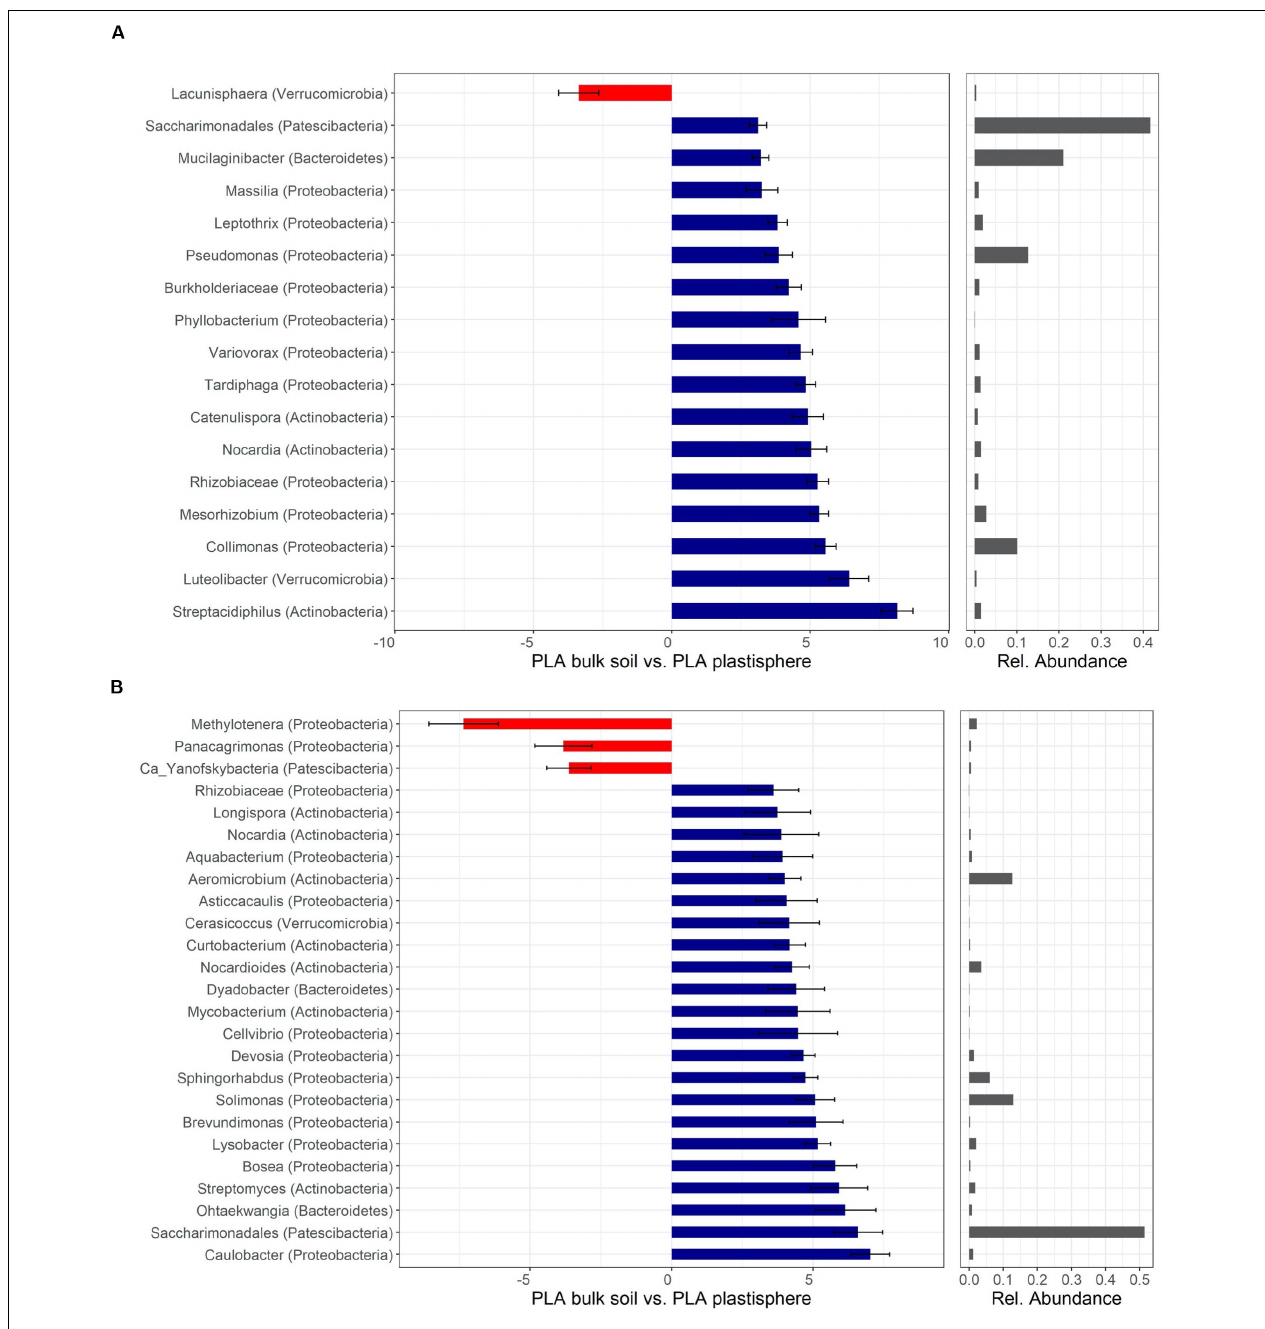
FIGURE 5 | Differentially abundant taxa of PLA in Barba Peider (Swiss Alps) (A) and Villum (Northern Greenland) (B) soil. Taxa are classified to the lowest possible taxonomic level. Values on the X -axis in the left panels show the differential abundances in the plastisphere and bulk soil as log 2 -fold changes. Only significant taxa ( P < 0.05) with log 2 -fold changes > 3 for panel (A) and > 3.5 for panel (B) are shown. Note that the scales in the x -axis in panels (A,B) are different. Positive values indicate a higher occurrence in the plastisphere, whereas negative values indicate a higher occurrence in the bulk soil. Names in brackets specify the phylum the taxa belong to. Values in the right panels indicate the abundances of specific taxa relative to the taxa shown in the figure. Ca, candidatus.